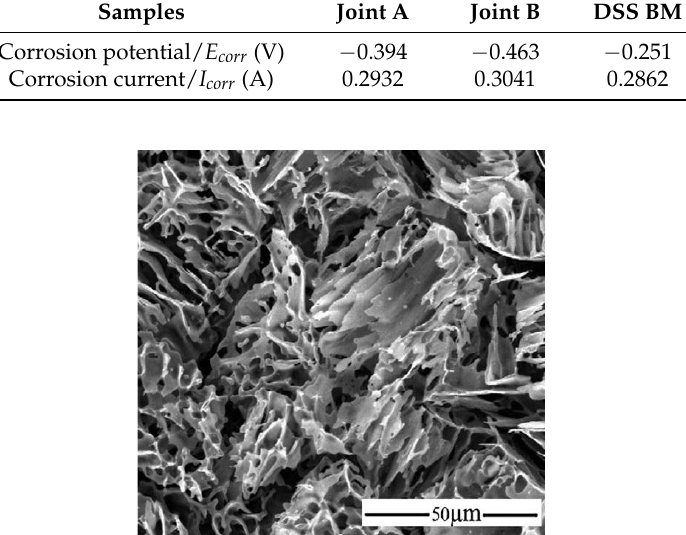
Figure 6. Scanning electron microscopy (SEM) micrograph of pitting corrosion.